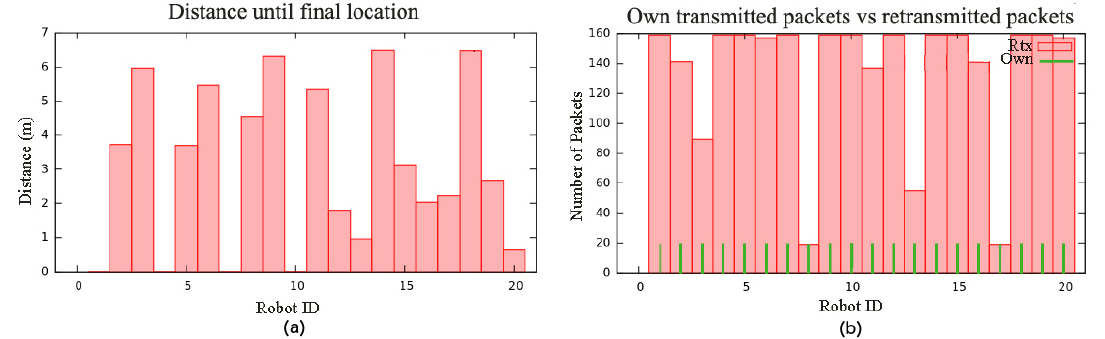
Figure 5. BDA deployment for 20 robots in an environment without obstacles: ( a ) d for every robot; ( b ) retransmission